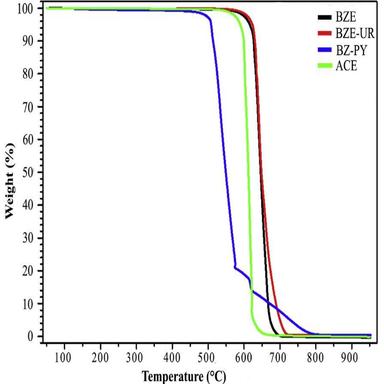
TGA analysis of N-CFS. The maximal lost weight occurred at 628, 641, 532, and 601 C for samples BZE, BZE-UR, BZ-PY, and ACE, respectively. The sample BZ-PY exhibited three oxidation temperatures, suggesting the existence of three different carbon materials. The weight of the remaining material at 950 C was almost negligible. N-CFS, nitrogendoped carbon fiber sponge; BZ-PY, pyridine-benzylamine; ACE, acetonitrile-ethanol; BZE-UR, BZE saturated with urea; BZE, benzylamine-ethanol; TGA, thermogravimetric analy